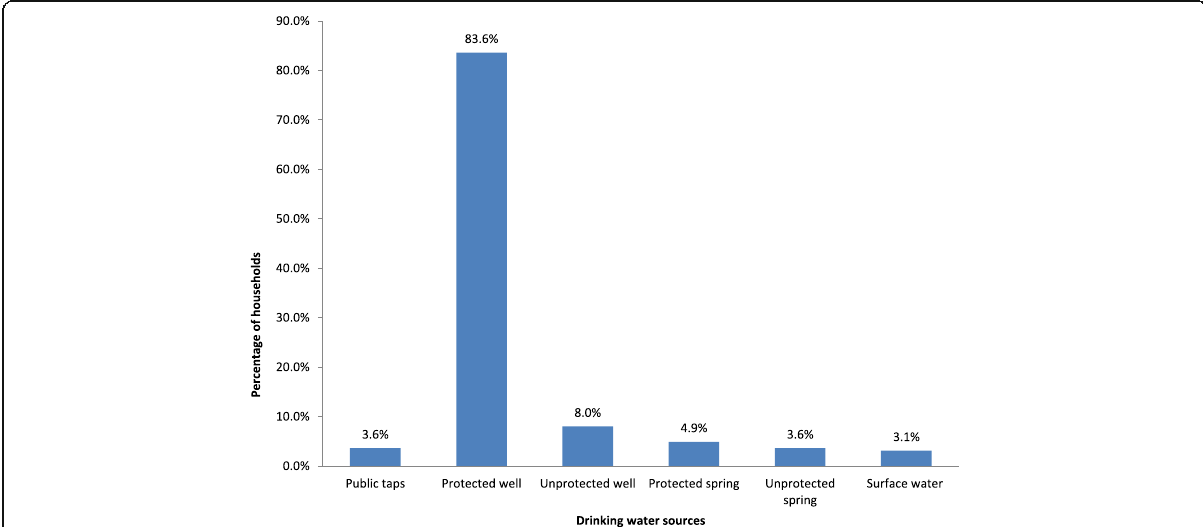
Fig. 2 Common drinking water sources for rural households in Dembiya, northwest Ethiopia, May